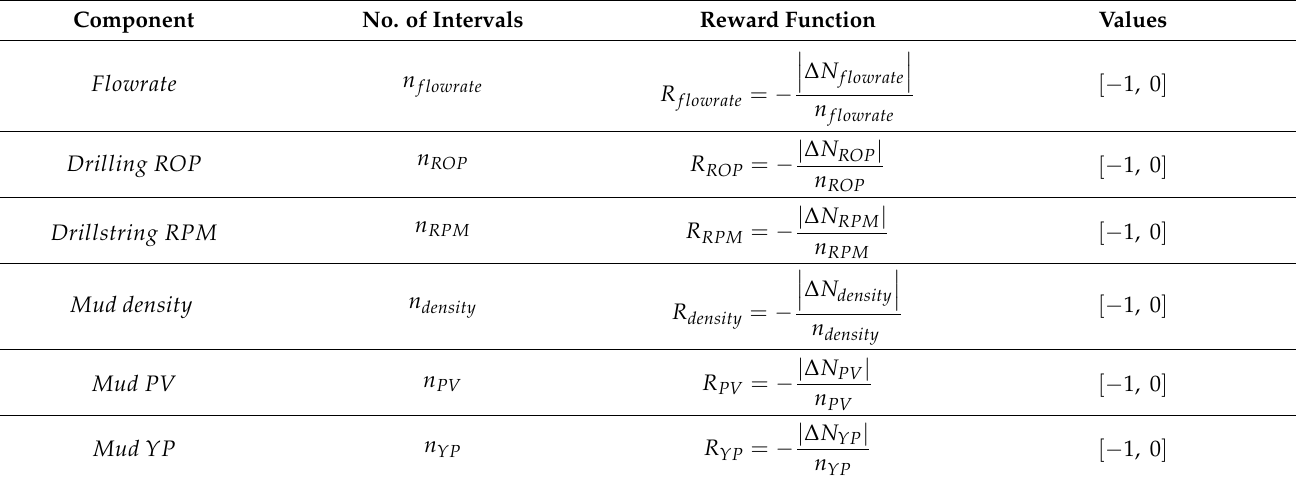
Table 2. Reward function associated with action transition.